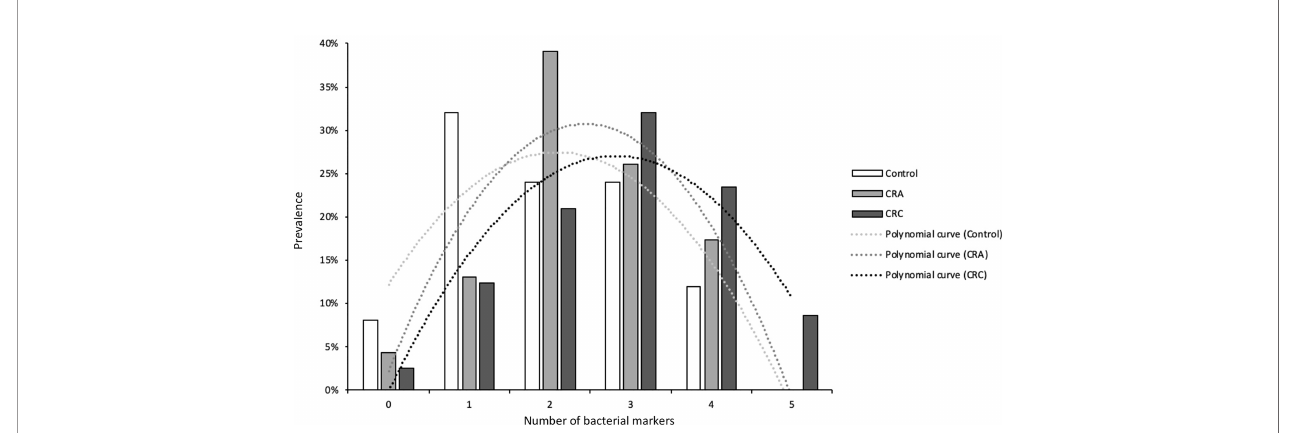
FIGURE 3 | The number of suspects bacterial markers found in the three groups: control, CRA, and